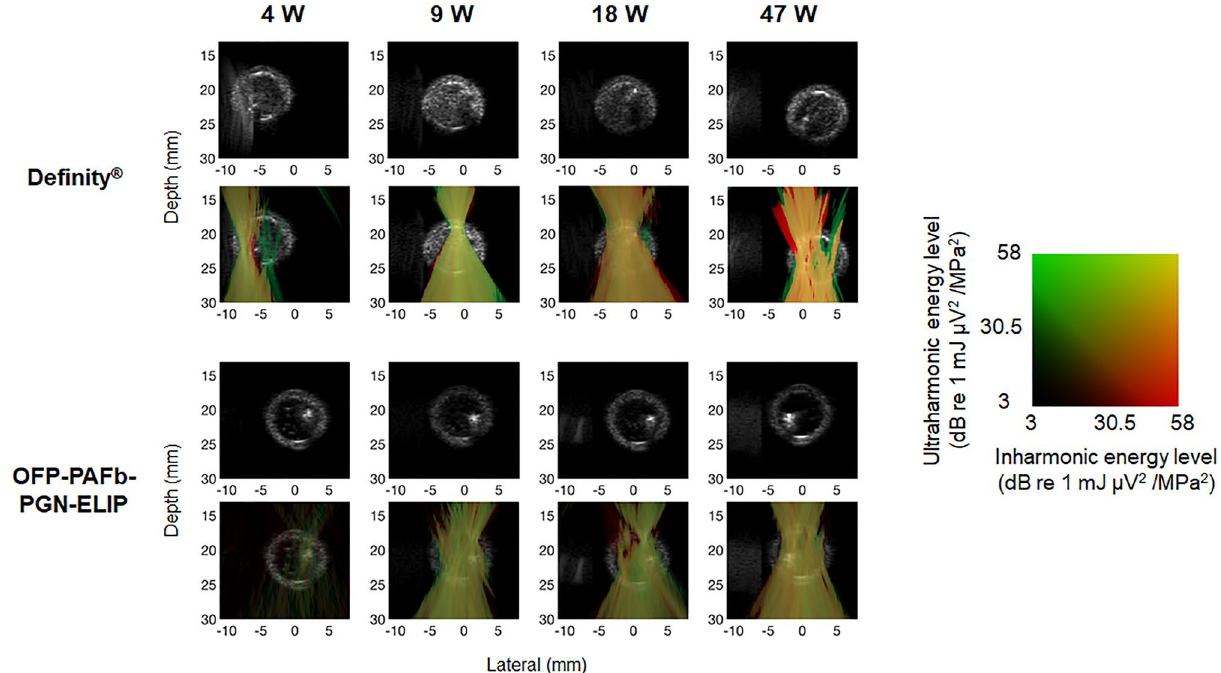
Figure 6. Composite PCI and B-Mode images of ultraharmonic (green) and inharmonic (red) emissions from cavitation nucleated by infused Definity or OFP-PAFb-PGN-ELIP insonified by one pair of EkoSonic transducers driven with 4, 9, 18, or 47 W electrical power. The B-mode images (visualizing echogenicity alone) are shown in rows 1 and 3, and the corresponding composite images are shown in rows 2 and